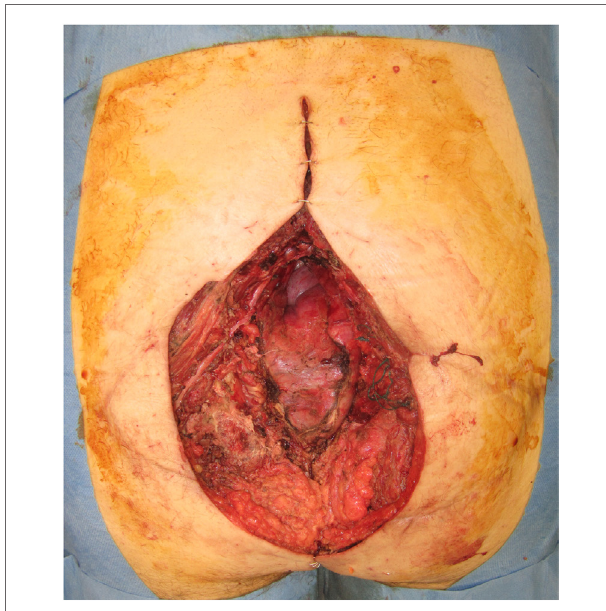
FigUre 8 | an 18 cm × 20 cm surface area sacral defect requiring reconstruction